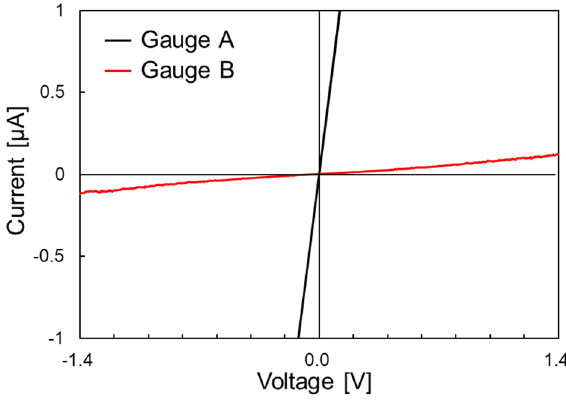
Figure 6. I–V characteristics of GNRs with a width of 50